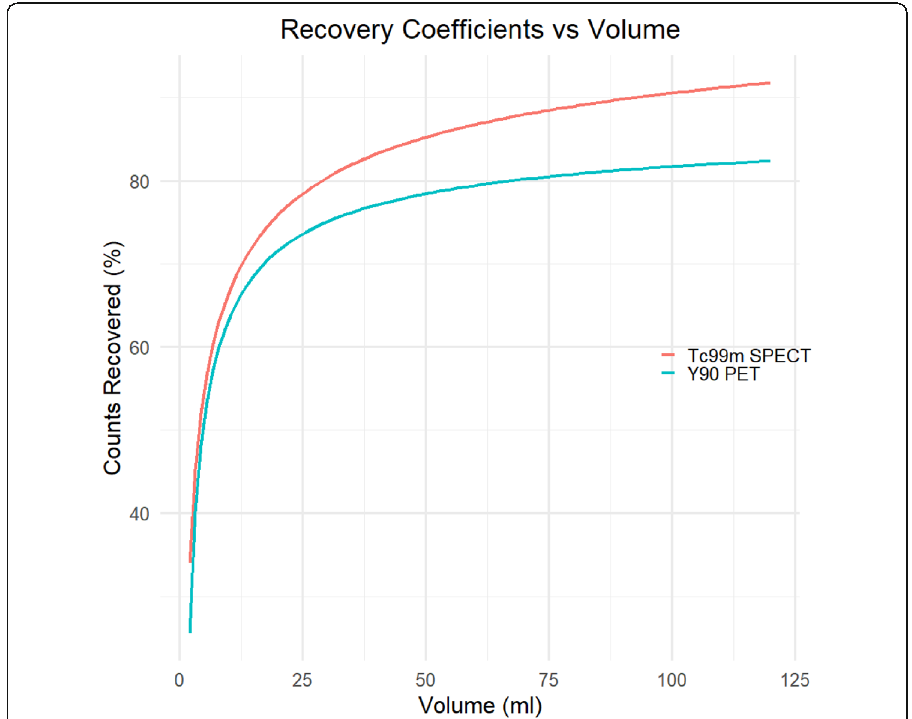
Fig. 1 Recovery coefficient curves for 90 Y PET and 99m Tc-MAA SPECT. Phantom acquisition and reconstruction parameters were as described for the patient